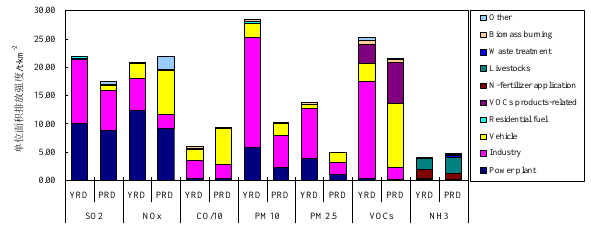
Fig. 4. Comparison of air pollutant emissions and source contributions in the YRD and PRD regions.